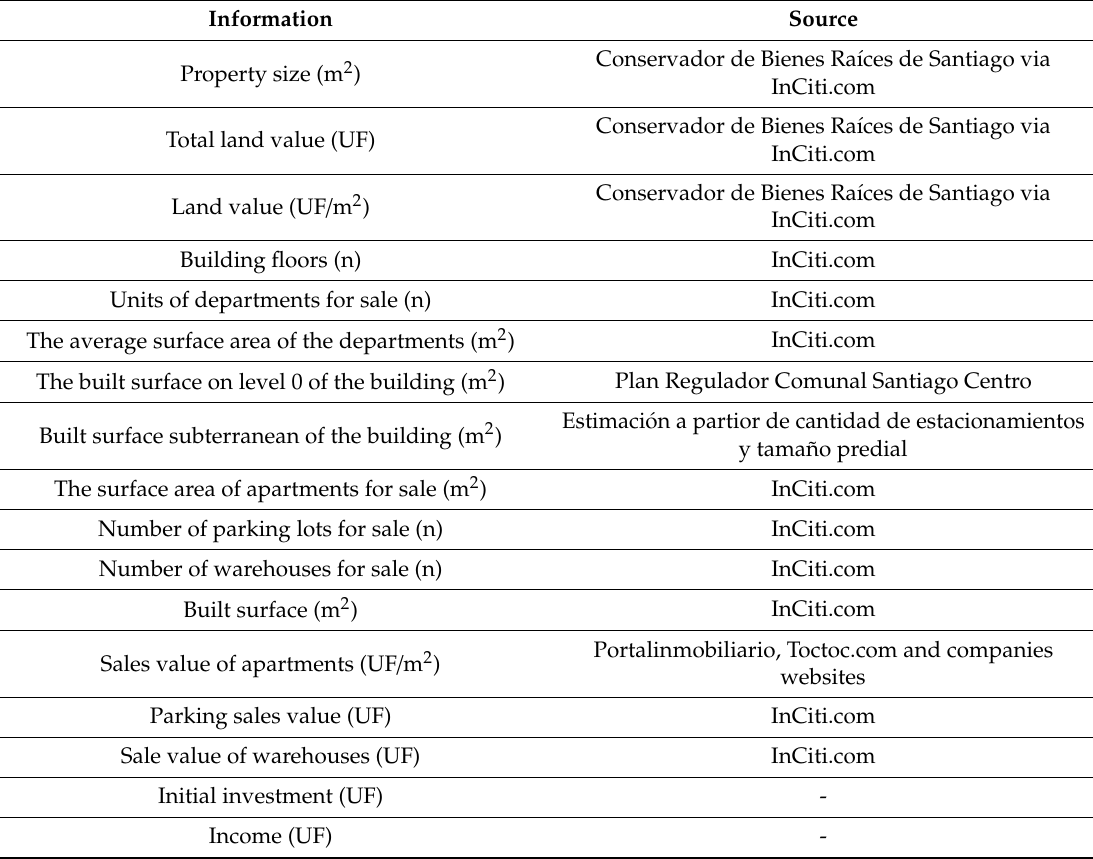
Table A2. Datasheet for profitability evaluation. Source: authors.